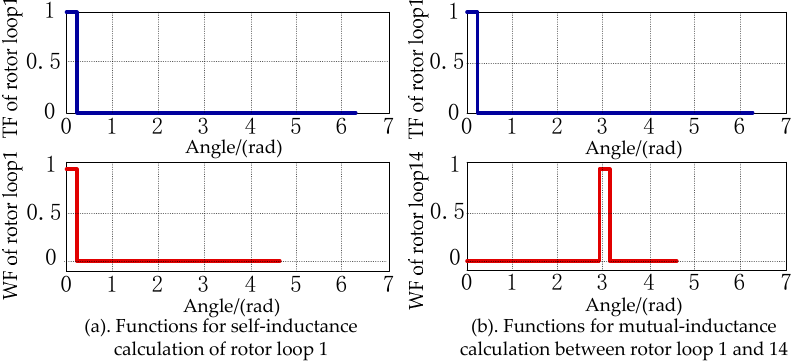
Figure 5. Turn functions (TF) and winding functions (WF) of rotor loops 1 and 14.